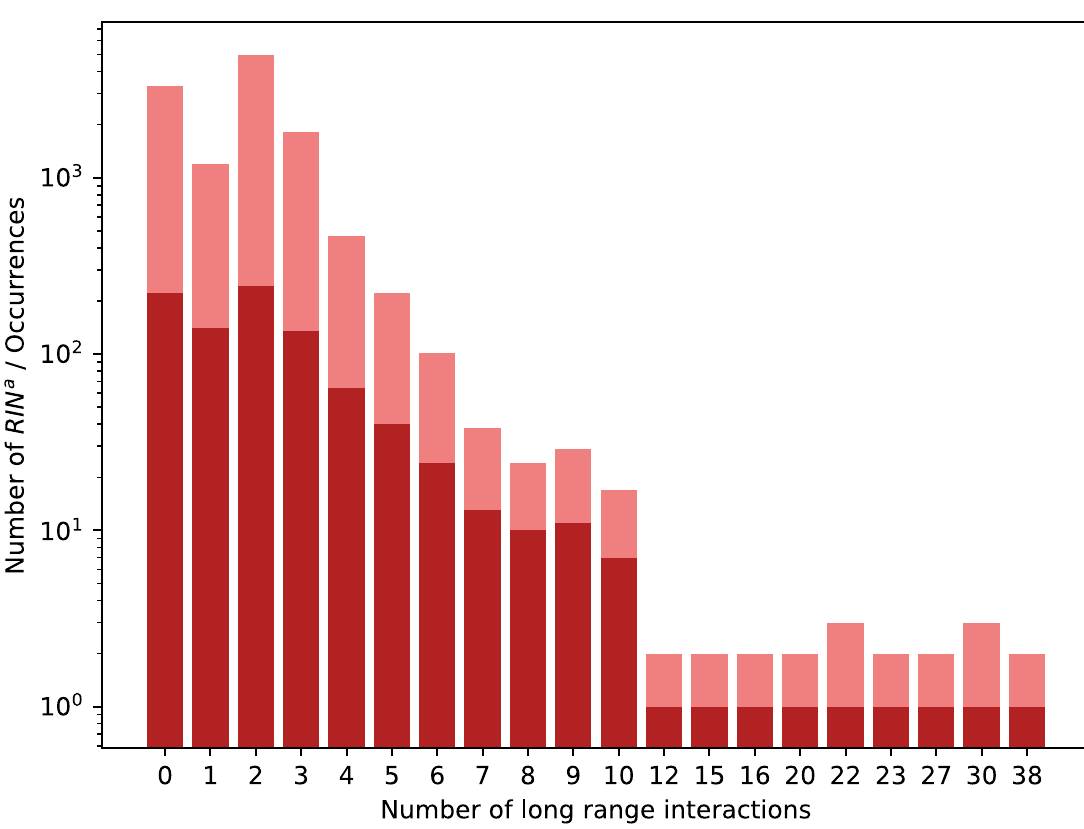
(in red) and all their occurrences (in rose) over the different s